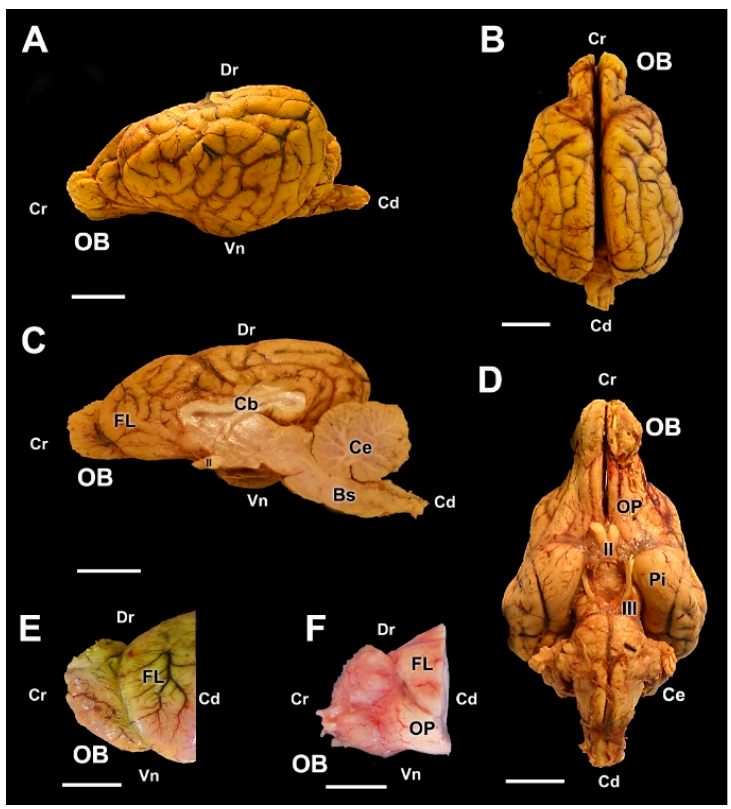
Figure 9. Macroscopic anatomy of the olfactory bulb (OB) of the wolf. ( A , B ) Lateral and dorsal view of the encephalon, respectively. ( C ) Medial view of the right hemiencephalon. ( D ) Ventral view of the encephalon. ( E ) Medial view of the right OB and the frontal lobe (FL) of the telencephalon. ( F ) Lateral view of the left OB and the frontal lobe of the telencephalon. (II) Optical nerve; (III) Oculomotor nerve; Bs, Brainstem; Cb, Callosal body; Ce, Cerebelum; OP, olfactory peduncle; Pi, Piriform lobe. Position terms: Cr, Cranel; Cd, Caudal; Dr, dorsal; Vn, Ventral. ( A – E ): Bouin’s liquid fixation. ( F ): Unfixed sample. Scale bars: ( A – D) : 2 cm; ( E , F ): 1 cm. Histological examination of the OB shows the typical mammalian lamination (Figures 10 and 11) with a degree of differentiation and development of the layers charac- teristic of macrosmatic species. The nerve and glomerular layers are particularly thick. Both the nerve and the glomerular layer were characterized by Nissl and hematoxylin– eosin staining (Figure 12). The GlL consisted of 2–4 layers of glomeruli, surrounded by a high density of periglomerular cells (Figure 12D). The mitral cell layer showed, in both transverse (Figure 13C,E) and sagittal sections (Figure 13A,B), numerous mitral cells (arrowheads) featuring either big triangular or miter-shaped somas and very well-defined multidendritic